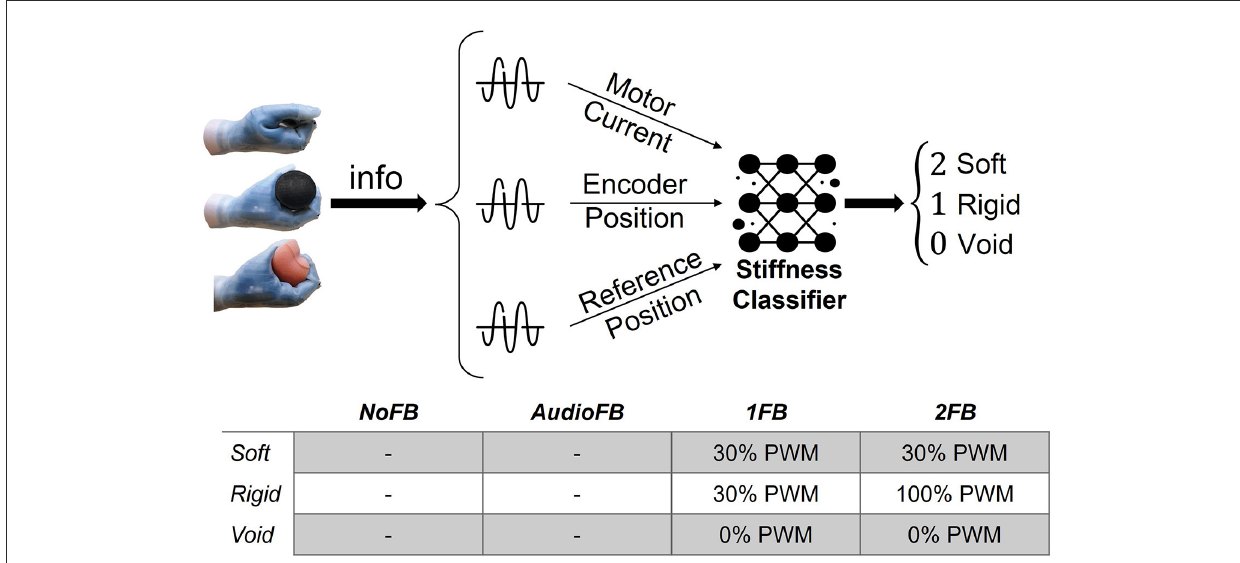
FIGURE2 Scheme representing the object stiffness classification process. The motor-side current, the reference, and the encoder positions are acquired from Hannes and sent as input to the classifier, which gives as output the resulting stiffness.